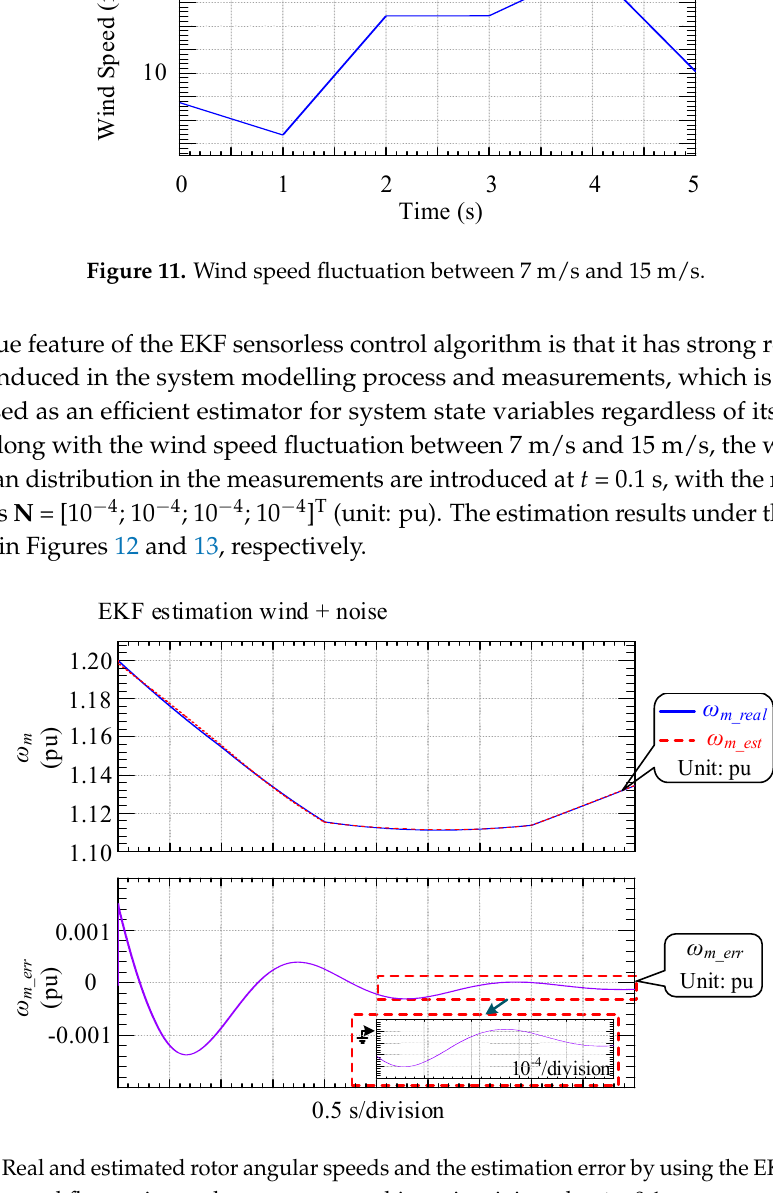
Figure 10. Real and estimated rotor positions and the estimation error by using the EKF algorithm when wind speed = 15 m/s.